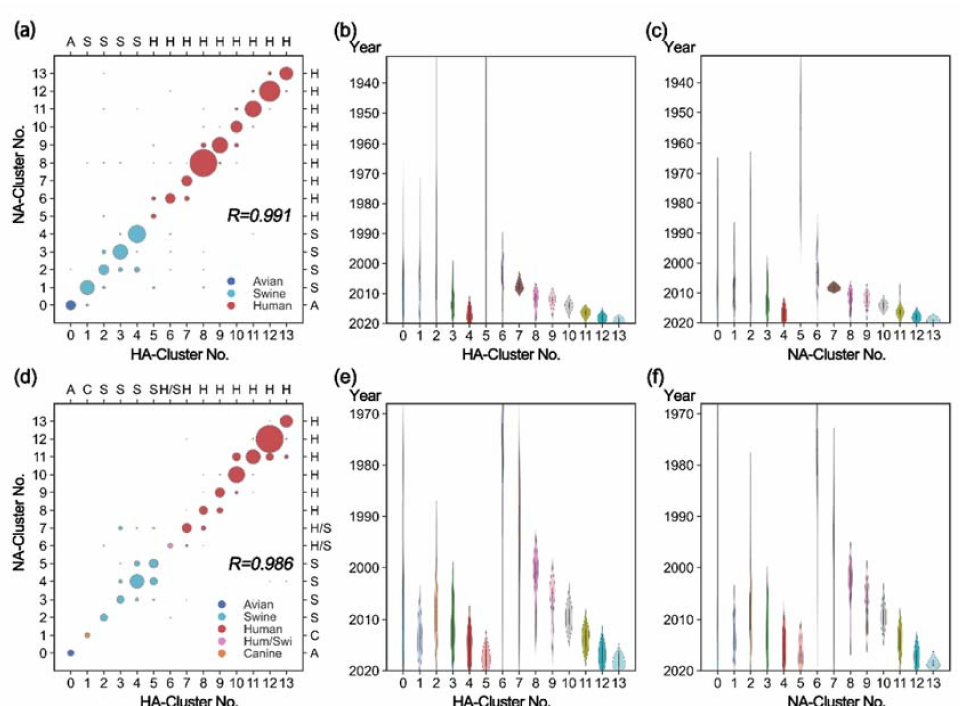
Figure 4. Cluster matching between HA and NA clusters. ( a ) Correlation between HA and NA clusters in A/H1N1. The color of the circle represents the type of host species and the size represents the number of contained strains. The more points on the diagonal, the stronger the linear correlation is; this is measured using Pearson coefficient with R = 0.991 in A/H1N1. ( b ) The violin plot shows the time evolution of each HA cluster of A/H1N1. ( c ) Time evolution of NA clusters of A/H1N1. ( d ) Correlation between HA and NA clusters in A/H3N2 with R = 0.986. ( e ) Time evolution of HA clusters of A/H3N2. ( f ) Time evolution of NA clusters of A/H3N2. The HA-cluster number and NA-cluster number are indicated in Figure 2. The abbreviations “A” (“Avian”), “C” (“Canine”), “S” (“Swine”), and “H” (“Human”) represent the dominant host species in each cluster. “H/S” (“Human/Swine”) indicates that both host species account for a large